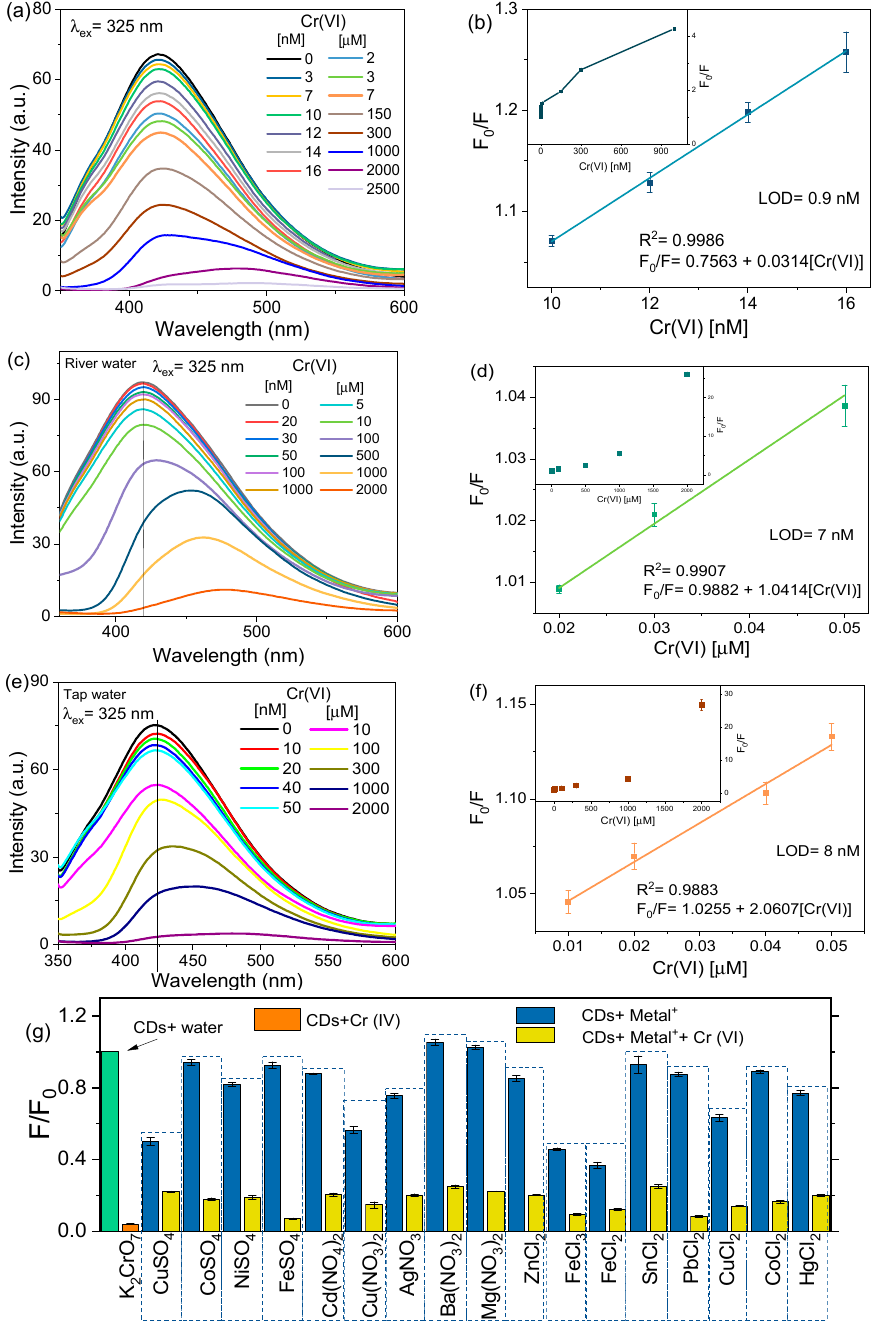
Figure 4. Sensitivity of CDs towards different concentrations of Cr(VI) in ( a ) DI water, ( b ) river water, and ( c ) tap water. Stern–Volmer fit, F 0 /F vs. 4-NP concentration for LOD calculation ( d ) in the range of 10 to 160 nM in DI water and ( e ) in the range of 20 to 50 nM in river water, ( f ) in tap water (10–50 nM), and ( g ) interference studies of metal ions vs. Cr(VI) detection. After a certain range, the relationship between concentration of the analyte and photoluminescence signal is not well correlated, which has been attributed to the differences in the interaction between the CDs and the analyte molecule [43], i.e., when the analyte concentration is increased, due to the limited number of CDs, the mutual interaction between analyte–CDs is reduced and the distance between the CDs and quencher is modified, as can be corroborated in the red shift of PL bands (in accordance with [44]).